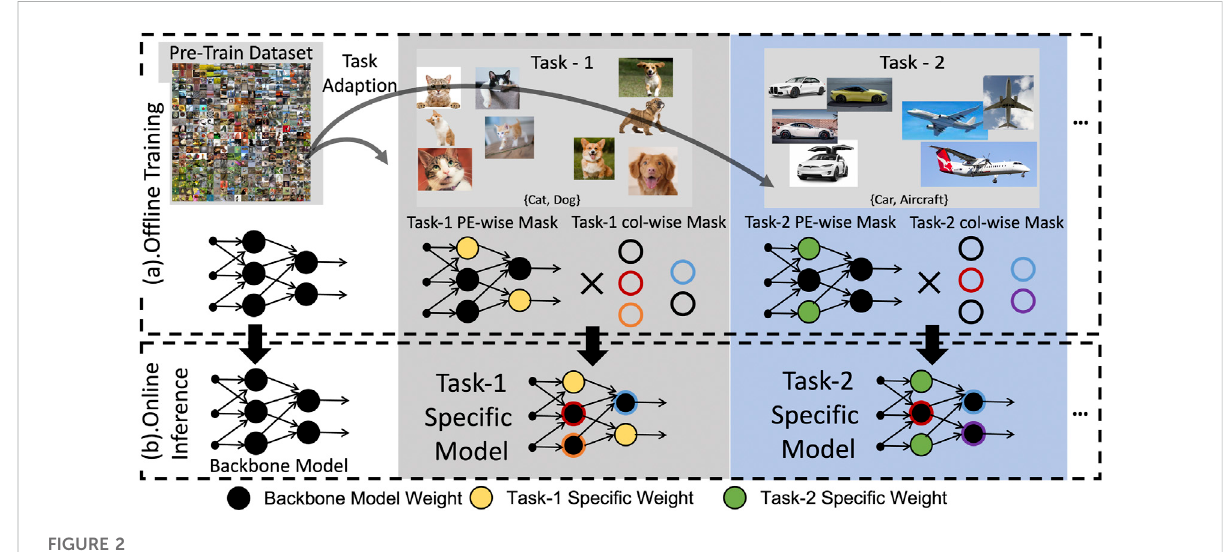
FIGURE 2 Overview of the crossbar-aware multi-task adaption framework, including PE-wise masking for retraining and col-wise masking for activation